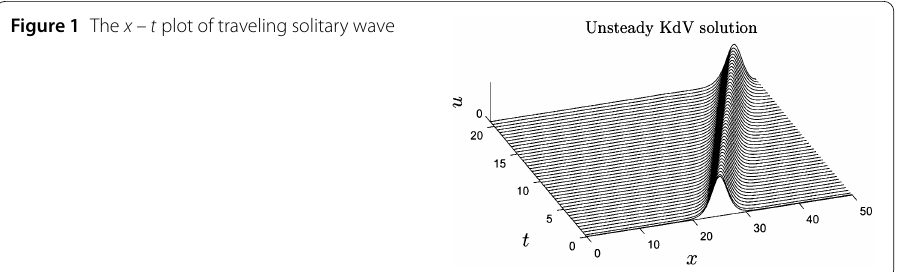
Figure 1 The x – t plot of traveling solitary wave